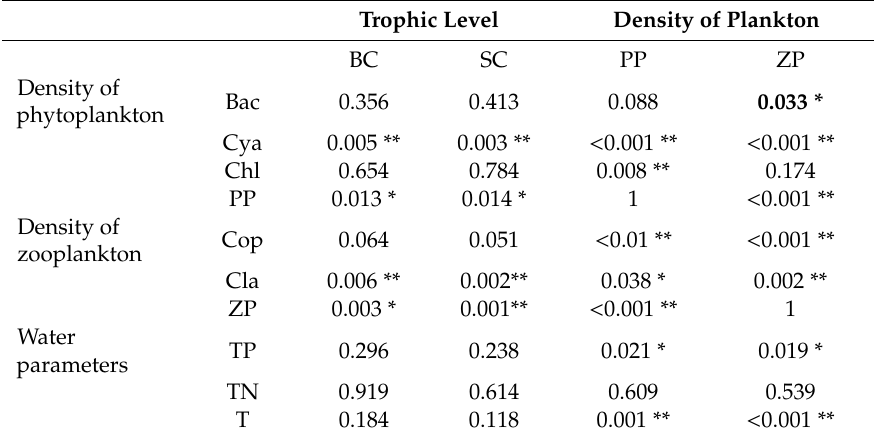
Table 3. Correlations between trophic patterns of fish and water environments in Lake Qiandao.